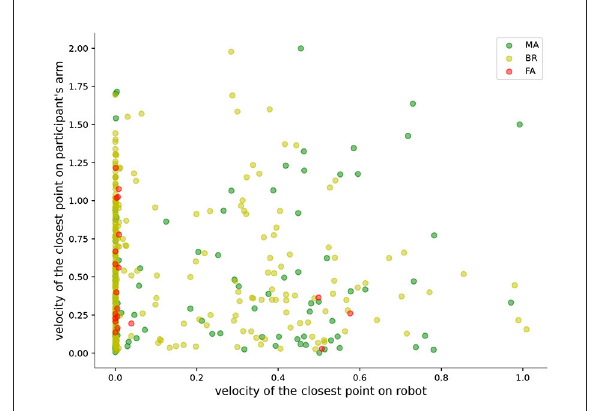
FIGURE7 Velocities of the pairwise closest points between the operator’s and the robot’s arm. MA, robot was moving away; BR, robot was braking; FA, robot failed to avoid operator arm.